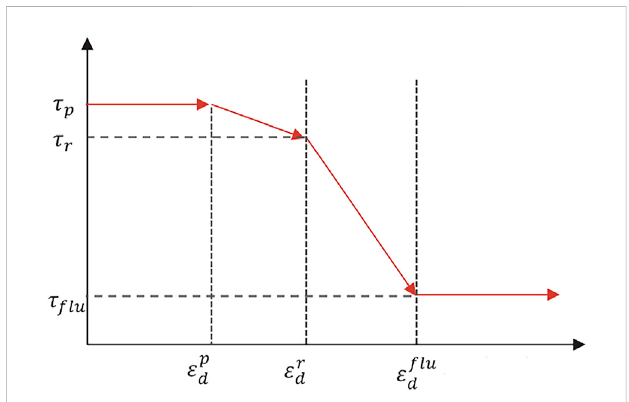
FIGURE 3 Strain softening model of an erodible material source Lee et al. (2019).